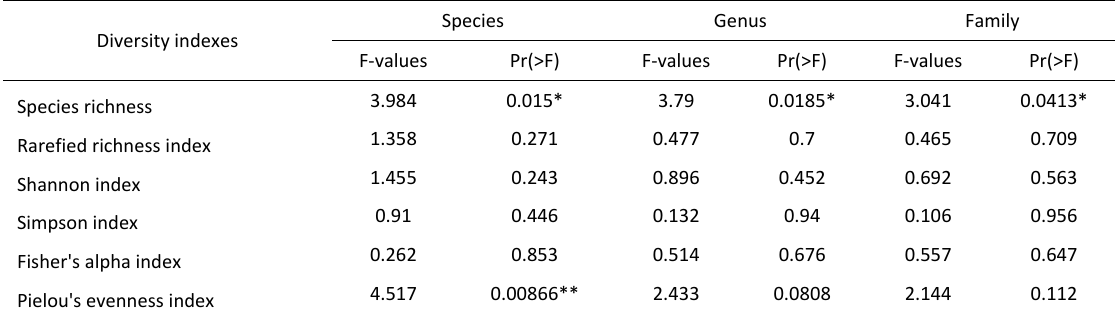
Table 1: F‐values of multivariate diversity in different taxons and peat depths. Table 1: F-values of multivariate diversity in different taxons and peat depths.